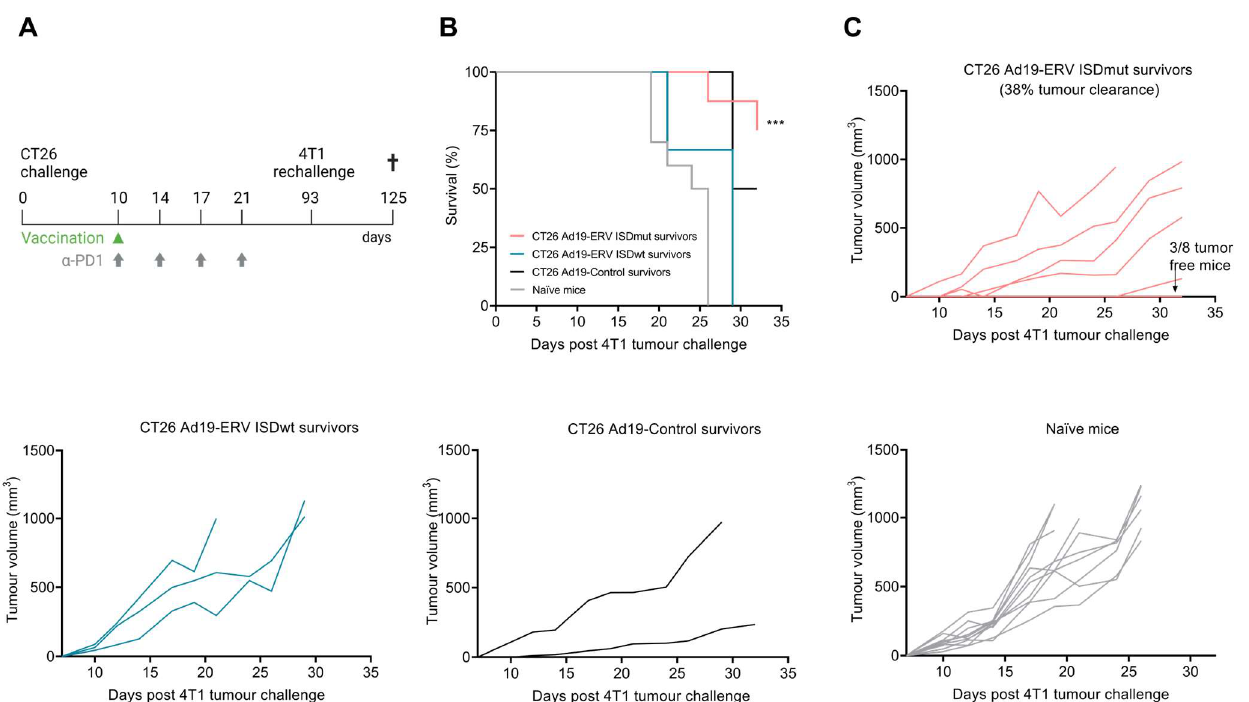
Figure 5. Ad19a/64-ERV ISDmut in combination with α -PD1 protects against rechallenge with a triple-negative breast cancer cell line . ( A ) Schematic representation of the tumour challenge and the therapeutic treatment. Ad19a/64-vaccinated BALB/c mice that survived CT26 challenge and naïve mice were (re)challenged with 1 × 10 4 4T1 tumour cells into the (left) thoracic mammary fat pad. Tumours were measured every 2–3 days. ( B ) Fraction of surviving mice over time after 4T1 rechallenge. ( C ) Measurements of tumour volume (mm 3 ) over time after 4T1 rechallenge. N = 2–10, ***: p < 0.001—Log-rank (Mantel–Cox) test. Ad19a/64 is referred as Ad19 in the figure.